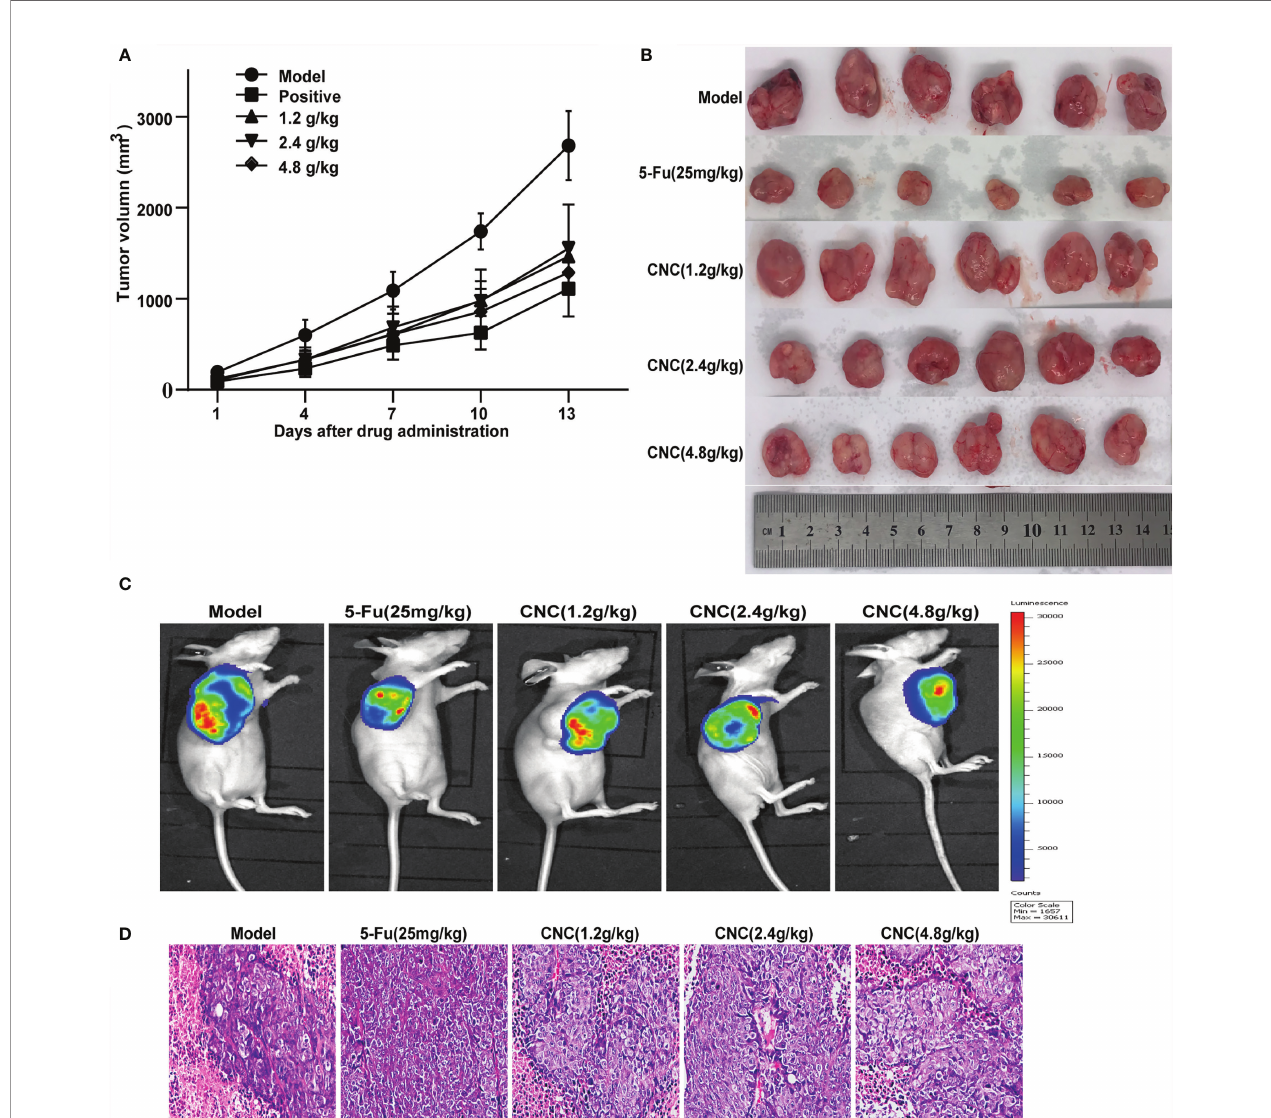
FIGURE 6 | CNC extract inhibited tumor growth in human HCT116 xenograft nude mouse model. (A, B) Tumor growth curves and volume in CNC extract- treatment and model groups. (C) Bioluminescence imaging of HCT116 xenograft tumors in different groups at the end of experiments. (D) HE staining of tumor tissues. There were six nude mice in each